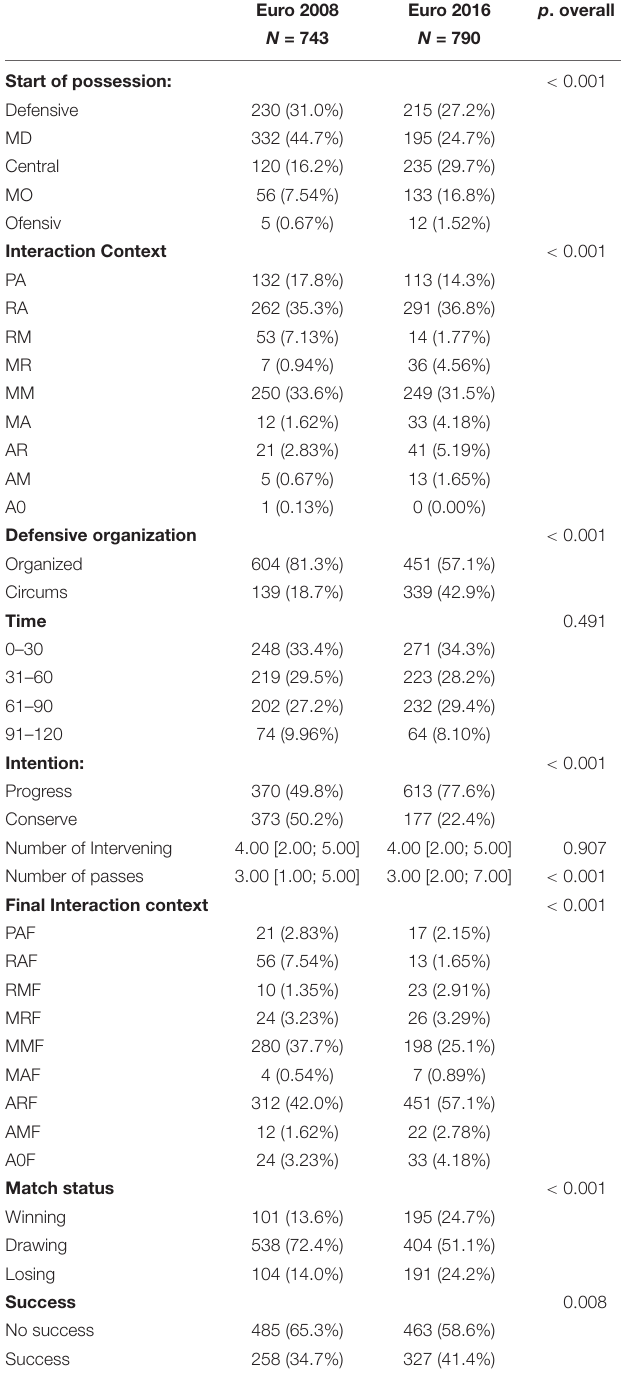
TABLE 2 | Summary descriptives table by groups of